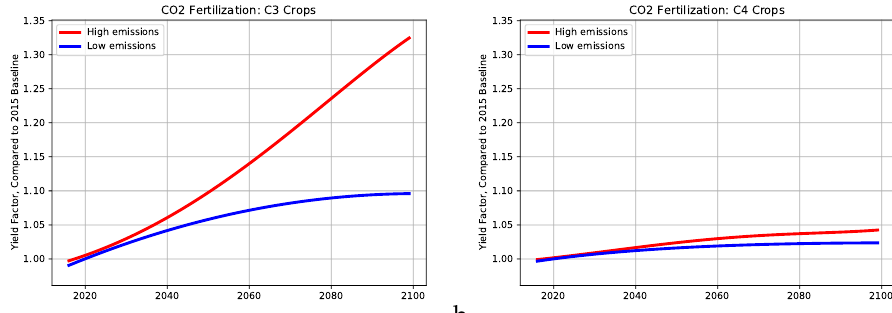
Figure 4. Yield factor for C3 ( a ) and C4 ( b ) crops through 2100 for a low (blue) and high (red) emissions scenario. Crop productivity under CO 2 concentrations was obtained from [44], and CO 2 concentrations for RCP4.5 and RCP8.5 are from